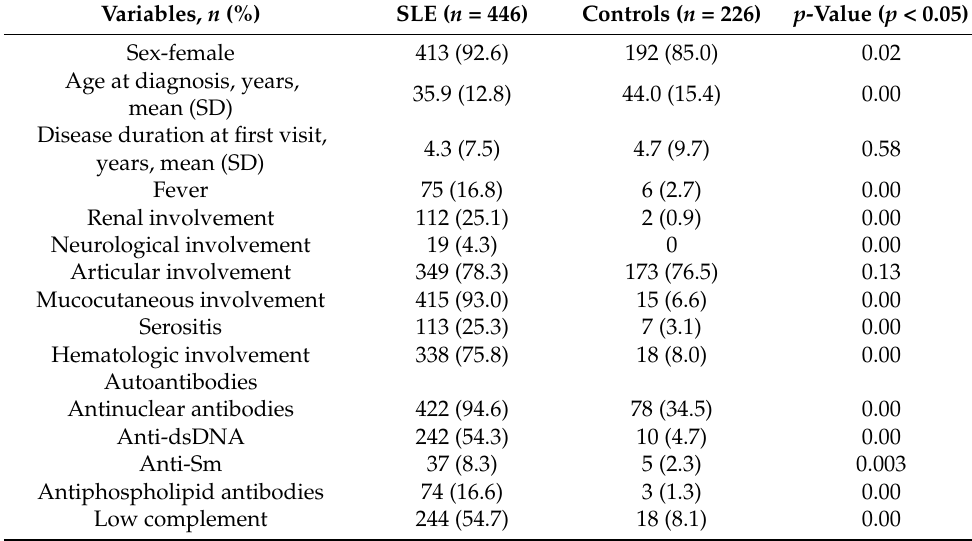
Table 1. Demographic and clinical characteristics of patients at diagnosis or first visit to our clinic. Variables, n